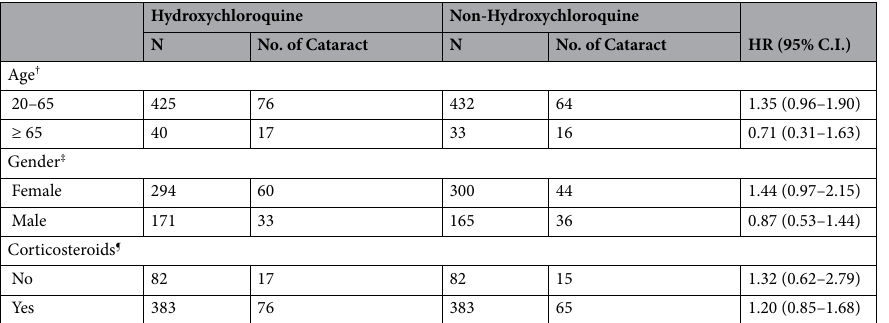
Table 4. Subgroup analysis of Cox proportional hazard model. † Adjusted for age, gender, hypertension, hyperlipidemia, chronic liver disease, chronic kidney disease, COPD, Diabetes, methotrexate, biologics, ophthalmology, and corticosteroids. ‡ Adjusted for age, gender, hypertension, hyperlipidemia, chronic liver disease, COPD, Diabetes, methotrexate, biologics, ophthalmology, and corticosteroids. ¶ Adjusted for age, gender, hypertension, hyperlipidemia, chronic liver disease, diabetes, methotrexate, and ophthalmology.